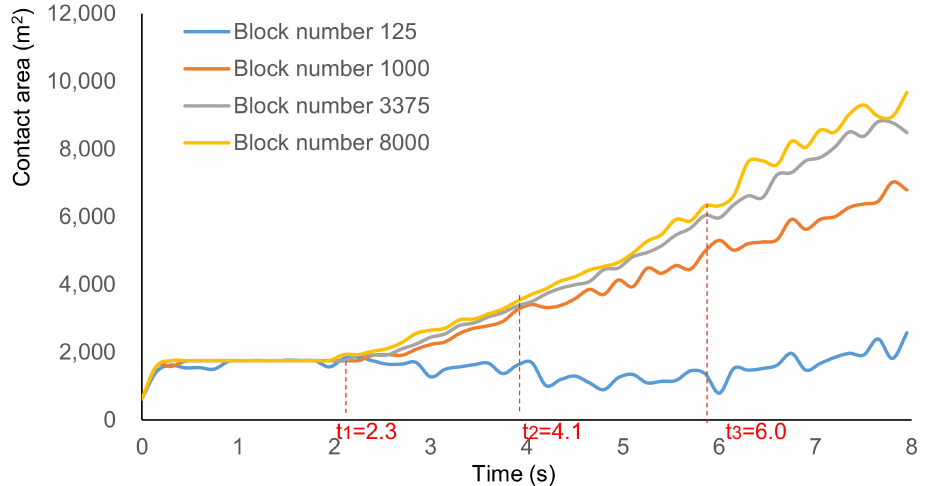
Figure 12. Contact area between blocks and slip surface from 0 s to 8 s under conditions of 125, 1000, 3375, and 8000 blocks. t 1 , t 2 and t 3 represent the time when the lowest breakage degree of sliding mass begins to have an obvious difference in the contact area from the sliding mass with higher breakage